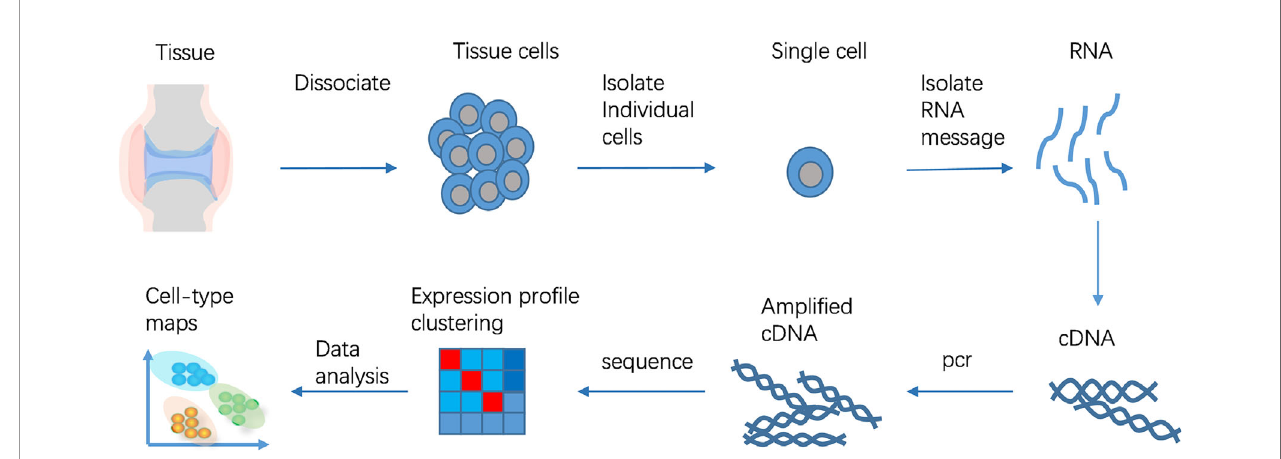
FIGURE 1 | ScRNA-seq work fl ow. The ScRNA-seq process includes isolation and cleavage of single cell or single cell nucleus, reverse transcription, cDNA ampli fi cation, construction of sequencing